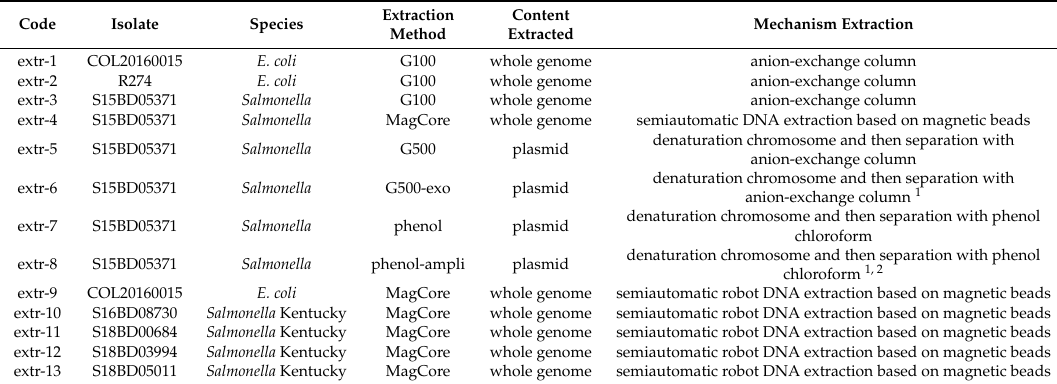
Table 1. DNA extraction methods applied in this study, their mechanism and isolates